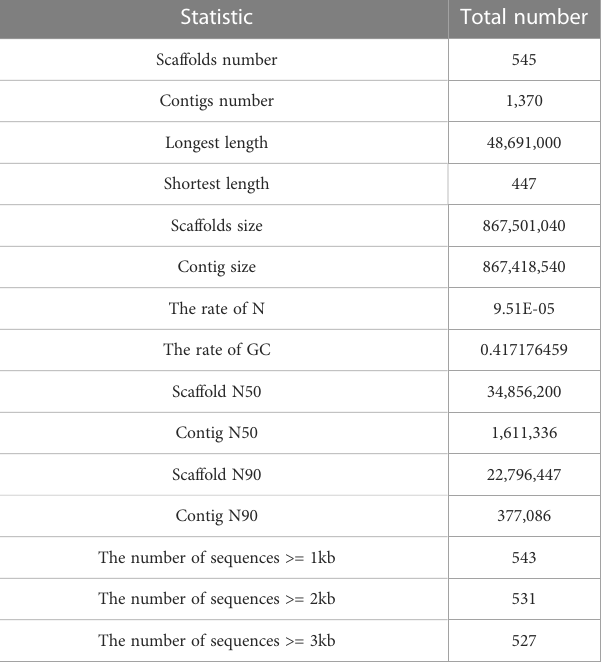
duplicated ” , 0.4% as “ fragmented ” , and 1.8% as “ missing ” (Figure 2B; Table S1). Second, 99.9% of the PE short-read sequences could be aligned to the genome sequences. Third, over 99.85% of the genomic regions had a coverage depth larger than 5. Collectively, these results suggest that we obtained a high-quality yellow box fi sh genome resource.